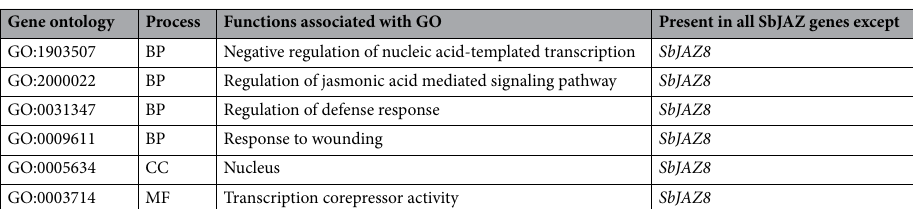
Table 3. Gene ontology of the sorghum JAZ genes. BP biological process, CC cellular component, MF molecular function.